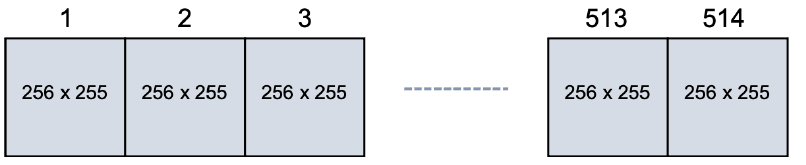
Figure 8. When applied to a N P = 256 × N B = 2 17 memory block, the data provided by an 8-bit ALFSR consist of a sequence of 256 × 255 arrays.